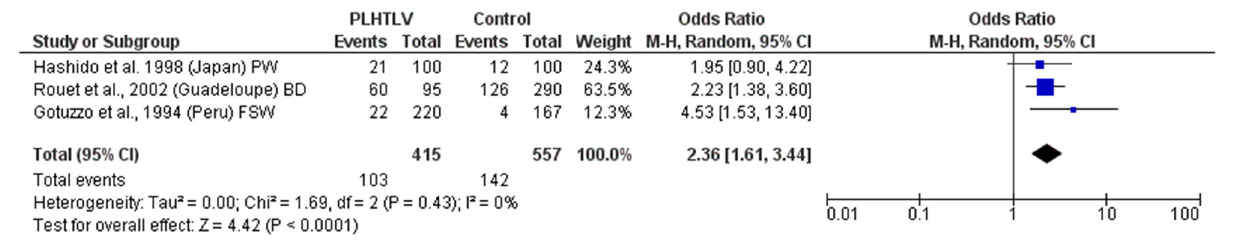
FIGURE 4 | Forest Plot and meta-analysis showing the Odds Ratio Chlamydia trachomatis infection in people living with HTLV-1. The boxes and lines indicate the odds ratios (ORs) and their confidence intervals (CIs) for each study. The pooled odds ratio is represented by a black diamond. The size of the blue squares indicates the relative weight of each estimate. Statistical analysis and graph were performed using RevMan 5 Software. Odds Ratio was calculated using Random effects model and Mantel-Haenszel statistical method. Measures of heterogeneity between studies is shown. PLHTLV, people living with HTLV; BD, blood donors; PW, pregnant women; FSW, female sex